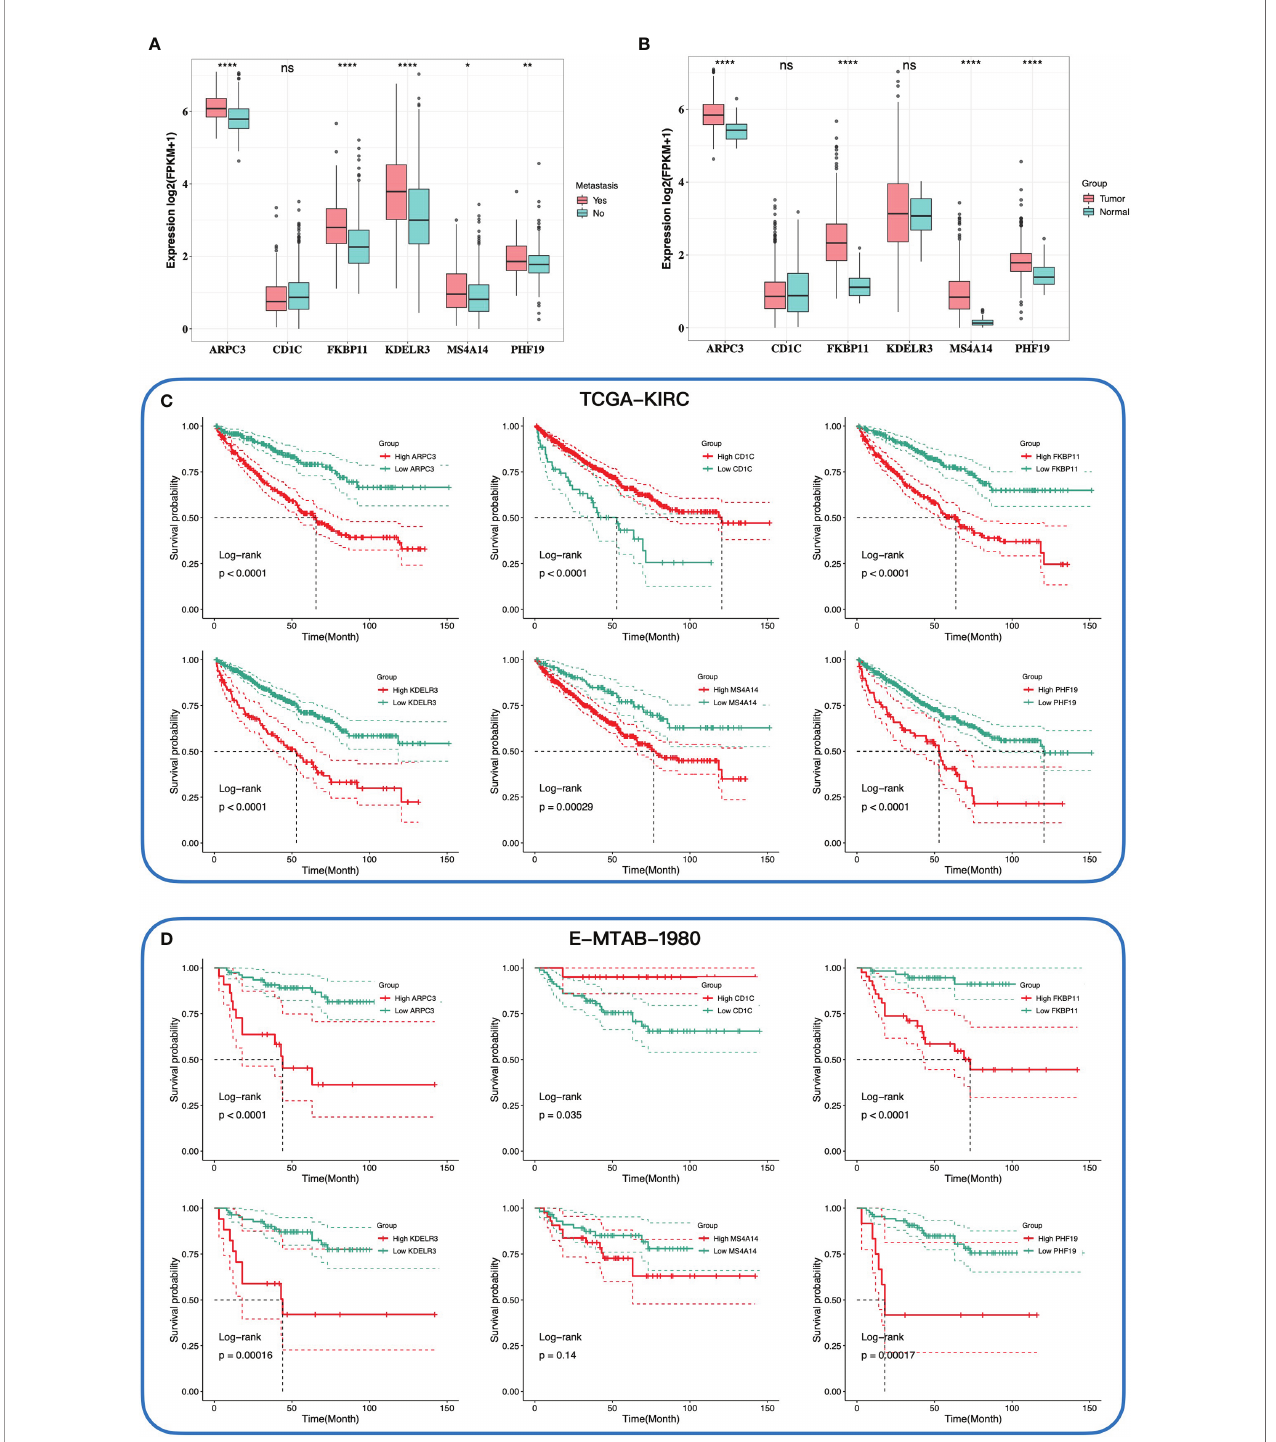
FIGURE 3 | The relationship between expression of six key genes and tumor, metastasis, and prognosis. The comparison expression of six hub genes in patients with and without distant metastasis (A) , and tumor tissues and normal tissues (B) . Kaplan – Meier survival curves of the overall survival of six hub genes in TCGA- KIRC cohort (C) and E-MTAB-1980 cohort (D) according to the optimal cutoff value of gene expression. * 0.01 < p < 0.05; ** 0.001 < p < 0.01; **** p < 0.0001; ns no signi fi